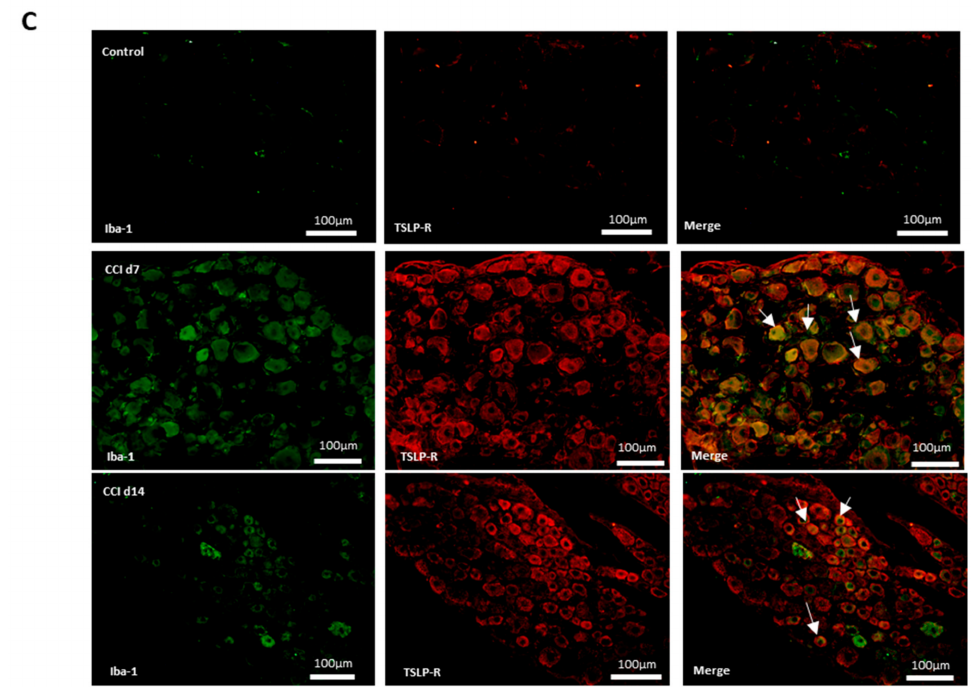
Figure 3. TSLP expressed in DRGs with neuron–glia interaction after CCI. Double-labeled im- munofluorescence imaging was performed in L4/5 DRGs of rats at 7 days and 14 days after CCI. ( A ) Representative double-labeled immunofluorescence images showing TSLP (green) with neuron marker NeuN (red). Scale bar, 50 µ m. ( B ) Representative double-labeled immunofluorescence images showing TSLP (green) with satellite glial-cell marker GFAP (red). Scale bar, 50 µ m. ( C ) Representative double immunofluorescence labelling results for TSLPR (red) with iba1 (green). Scale bar, 100 µ m. Pairs of images are merged. White arrows indicate doubled-labeled cells. N = 6 per